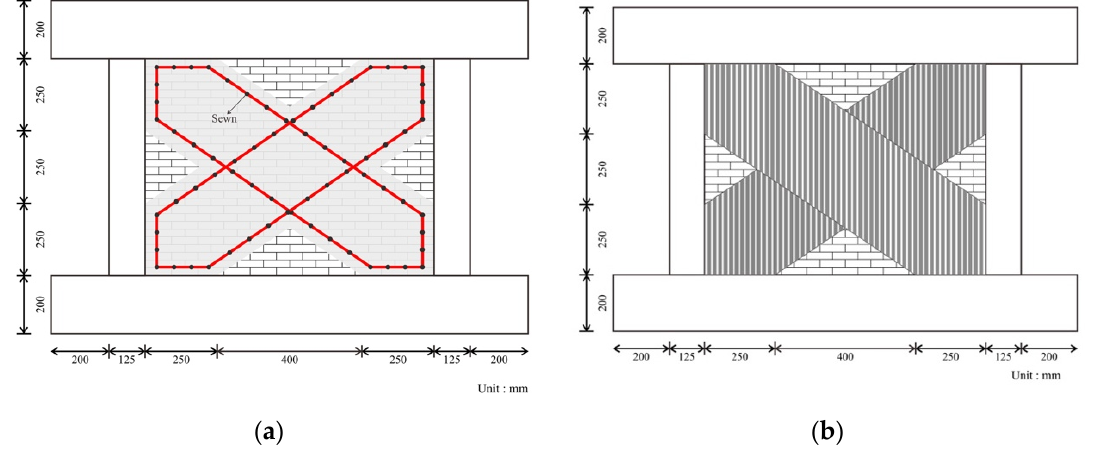
Figure 2. Sketch of strengthening method of infills. ( a ) Strengthening the infill with textile plastic reinforcement mesh/steel wire mesh/chicken hexagonal wire mesh. ( b ) Strengthening the infill with fiber-reinforced polymer/plastic stretch film.